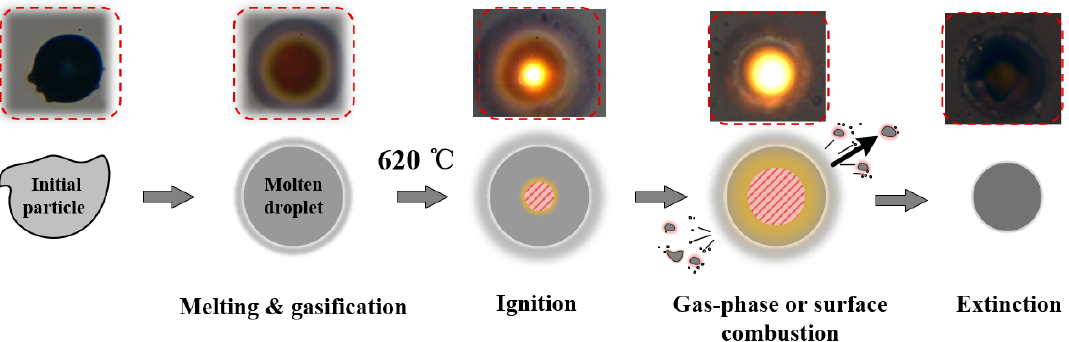
Figure 18. Schematic diagram of combustion route of single Al-Li alloy microparticles in air. For a micron-sized Al particle, due to its high volumetric heat capacity, it usually needs to reach or approximate the melting point (~2350 K) of the Al 2 O 3 shell to achieve ignition [4,30], and its combustion usually occurs on the surface, without an obvious mi- croexplosion. However, for an Al-Li alloy microparticle, during melting, the Li in the Al-Li droplet gradually vaporizes and forms bubbles inside the microparticle owing to the limitation of the oxide layer (shell). When the expansion pressure inside the bubble quickly increases and exceeds the surface tension of the molten Al droplet, the breakup of the surface occurs. Thus, the molten Al is constantly sprayed from the core. If the pressure is much higher than the surface tension, unloading leads to the occurrence of a microex- plosion [22]. After the microexplosion, the remaining Al-Li alloy experiences repetitive processes until extinction. Moreover, during the melting of Al-Li alloy microparticles, on the surface oxide layer, cracks appear earlier, which give way to the diffusion of oxygen atoms (inward), and Al and Li cations (outward), resulting in ignition. It is worth noting that Li cations have a higher diffusion rate than Al cations; thus, they can diffuse to